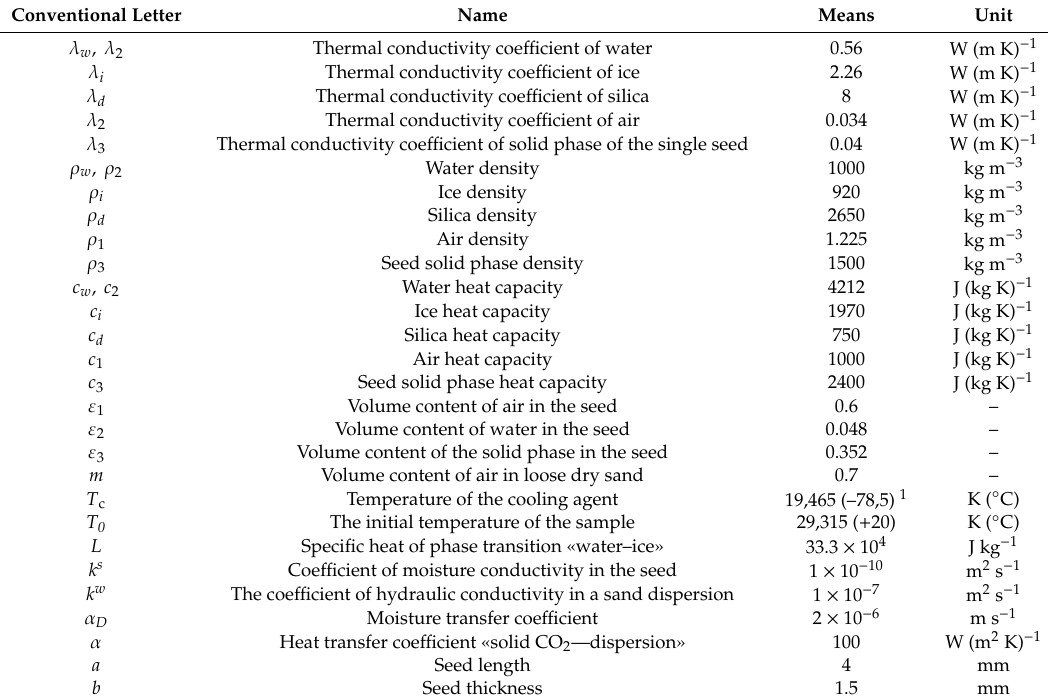
Table 1. Calculated parameters for numerical experiment of freezing a single pine seed in a water-saturated dispersed